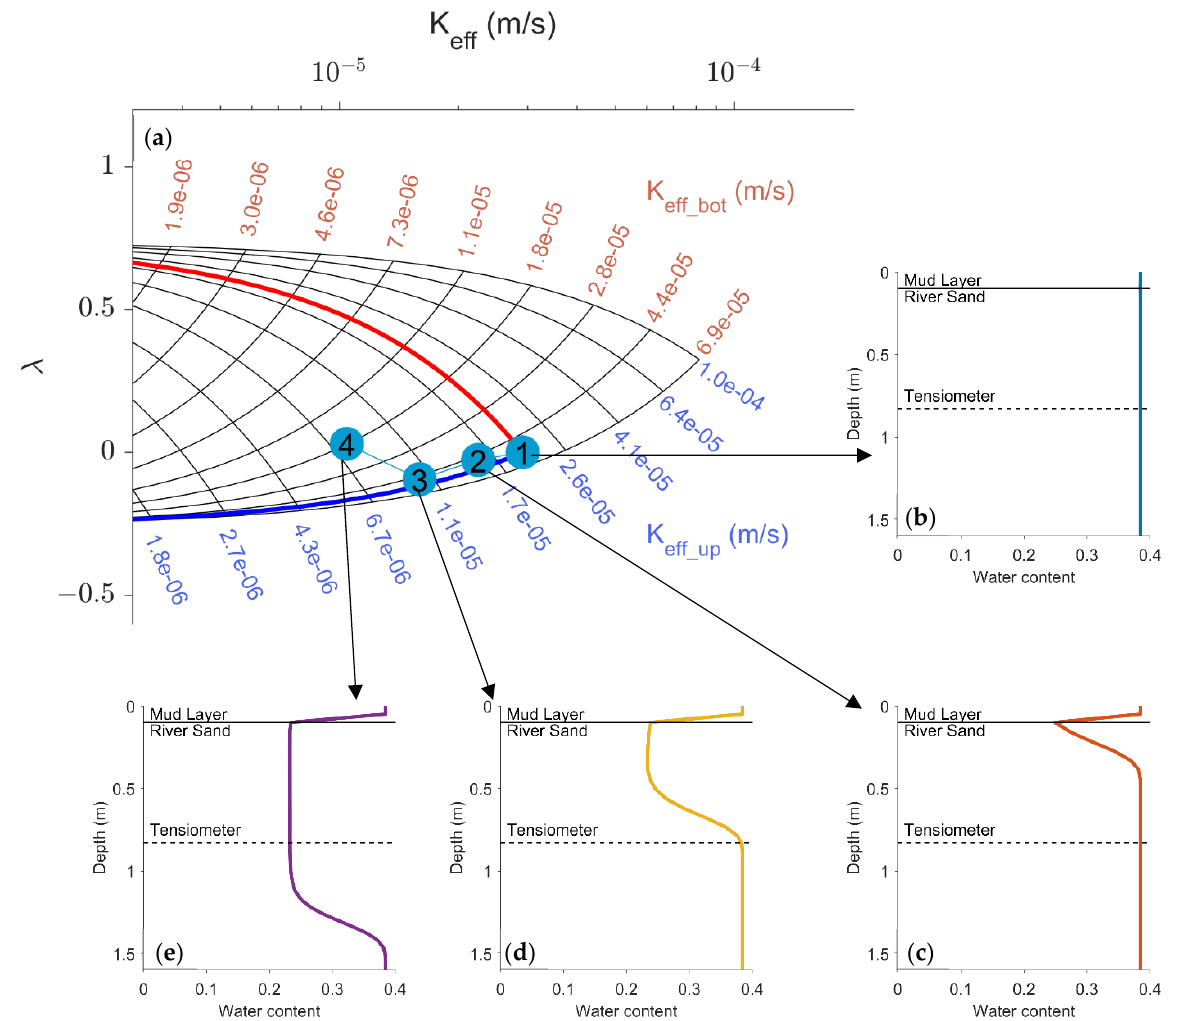
Figure 9. The simulation results in the upper clogging scenario. ( a ) The overall evolution of clogging in the height of stainless-steel pipe (h s ) with ( b ) 1.5 m, ( c ) 1.1 m, ( d ) 0.7 m, and ( e ) 0.0 m. The upper black solid lines in ( b ) to ( e ) present the height of the bottom of the mud layer, while the black dash lines show the height of the tensiometer in the